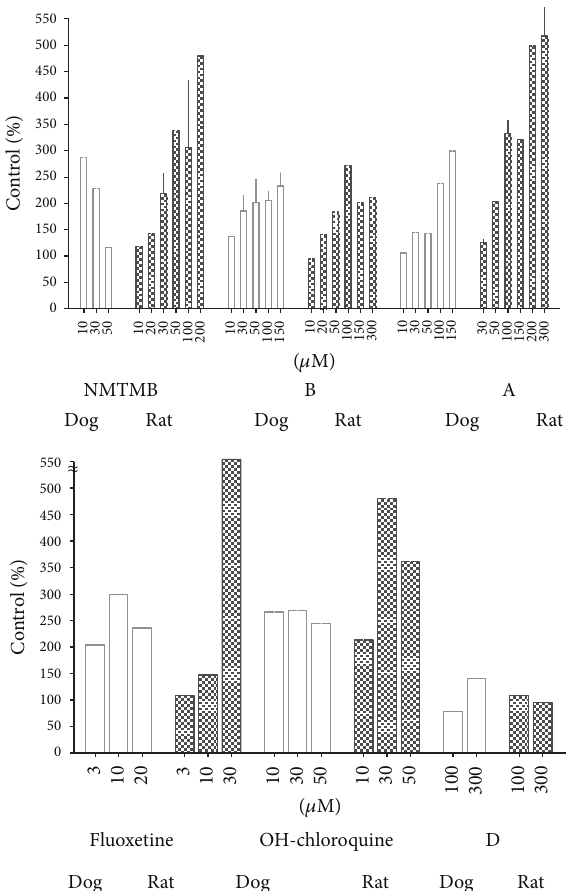
Figure 3: Differential effects of phospholipogenic test articles on accumulation of the fluorescent phospholipid NBD-PE on dog and rat hepatocytes. Cells were treated with known phospholipogenic or nonphospholipogenic compounds in NBD-PE containing media. After 24h cells were fixed with formaldehyde/hoechst, and NBD-PE accumulation was quantified using the Cellomics Arrayscan instru- ment. Image exposures were identical in all experiments (0.5 sec); background levels of NBD-PE accumulation were similar between dog and rat hepatocytes (approximately 50 mean average intensity units). Accumulation is expressed as % VC (vehicle control) at listed concentrations. Three replicates for each cell isolate were employed per experiment. Isolations occurred on separate days. The data are represented as an average of individual experiments where 𝑁 = 1 - 2 (where histograms do not have error bars) or an average of 3 independent isolates ±